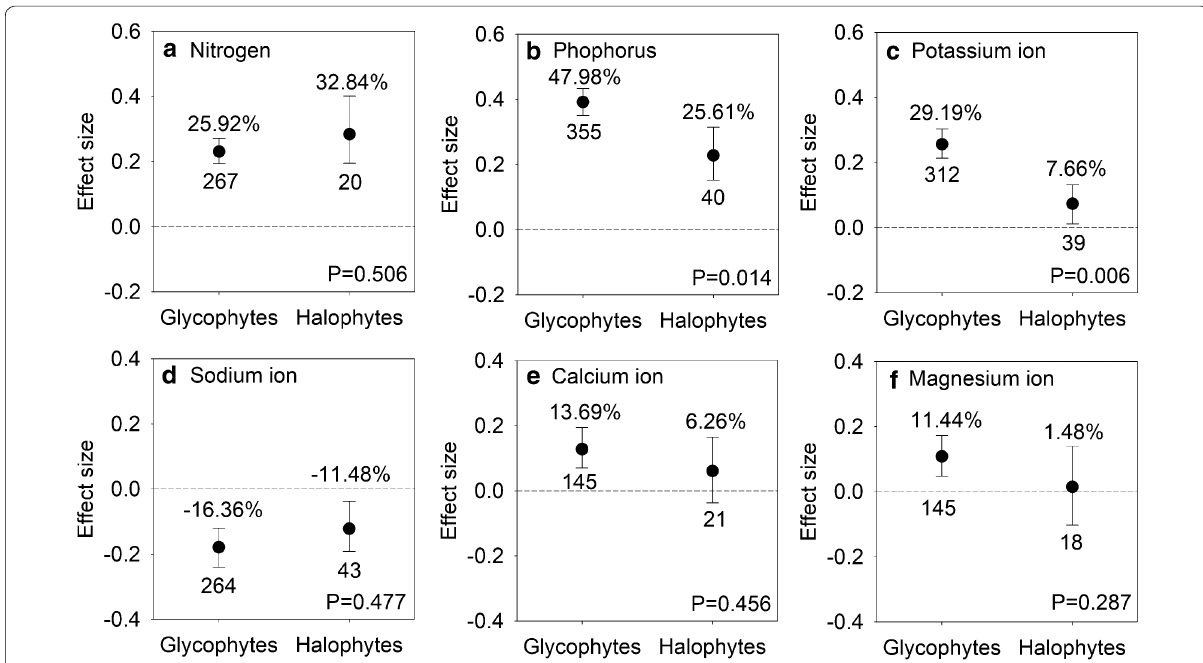
Fig. 3 Responses to salt stress of nitrogen ( a ), phosphorus ( b ), potassium ion ( c ), sodium ion ( d ), calcium ion ( e ), and magnesium ion ( f ) in AMF-inoculated halophytes and glycophytes. Error bars represent 95% confidence intervals (CIs). Back-transformed effect sizes are shown above the bars. The numbers of studies are shown under the bars. Inoculation effects were considered significant when the 95% CIs did not overlap with zero. The P values for each panel reflect the significant differences between halophytes and glycophytes